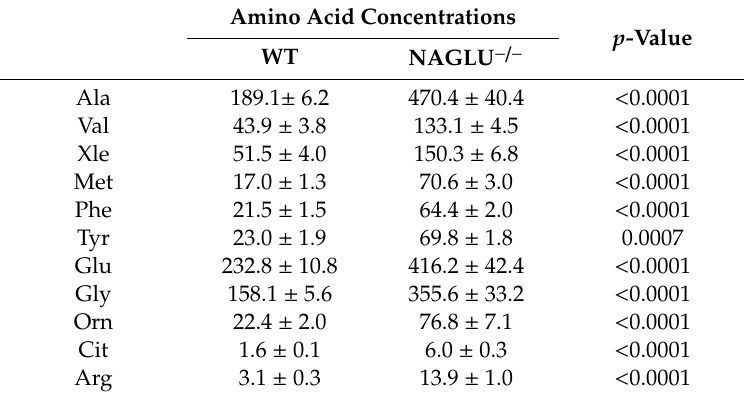
Figure 5. Amino acid accumulation in the liver of NAGLU − / − mice. Results are represented as the mean ± standard error of the mean (SEM). The statistical significance of the di ff erence in metabolite tissue concentrations between genotype conditions (NAGLU − / − and WT) was evaluated by parametric or non-parametric tests when data failed the Shapiro–Wilk normality test. *** p < 0.001, **** p < 0.0001. Table 2. Di ff erentially abundant metabolites in the